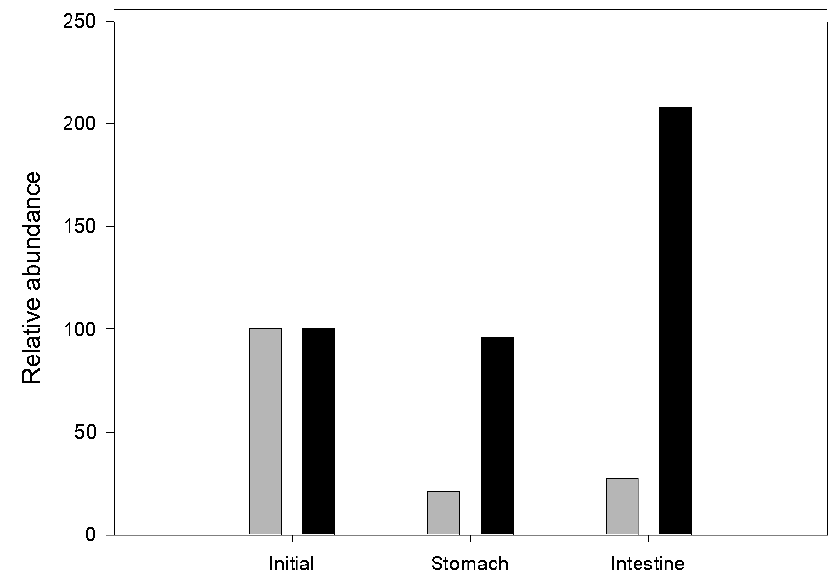
Figure 4. Relative abundance of roflumilast ions after stomach and intestine digestion without CD (gray) and with HP β -CD (black). The data are normalized using initial roflumilast abundance.